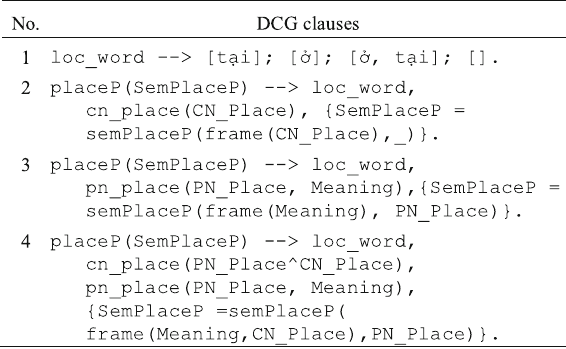
Table 8 DCG clauses are used to compute and infer the semantics of place